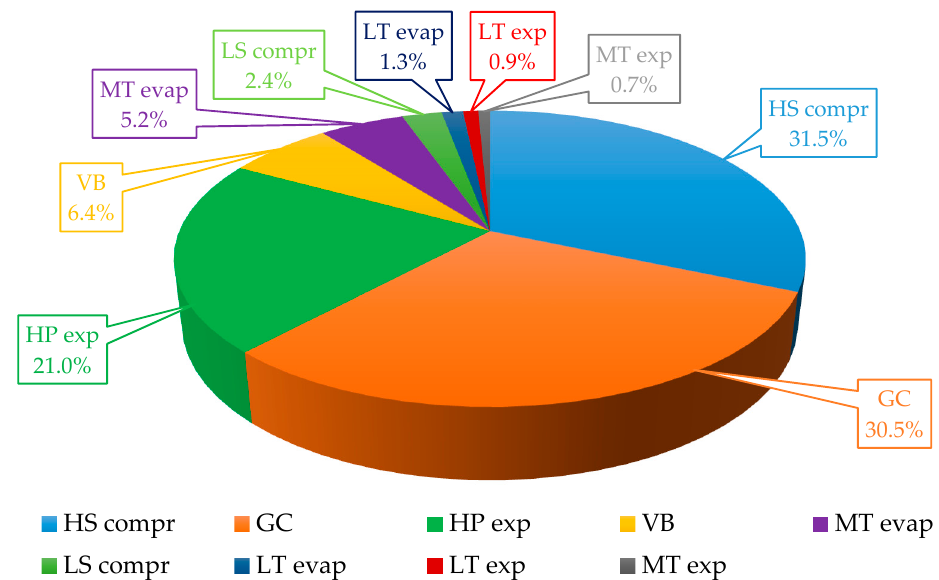
Figure 4. Breakdown of the contribution (%) of each component belonging to CB to the total exergy destruction rate at the outdoor temperature of 40 °C.